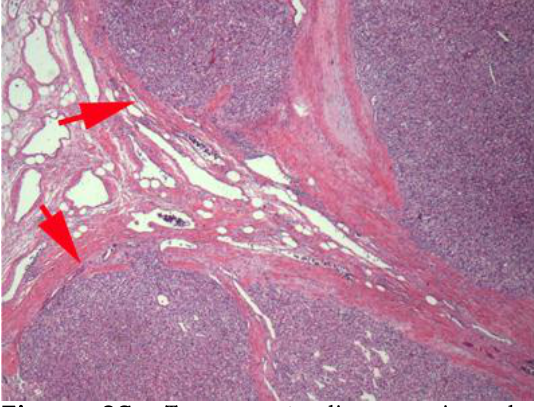
Figure 3C. Tumor extending as irregular tongues into perinephric tissues with or without desmoplasia is considered perinephric fat